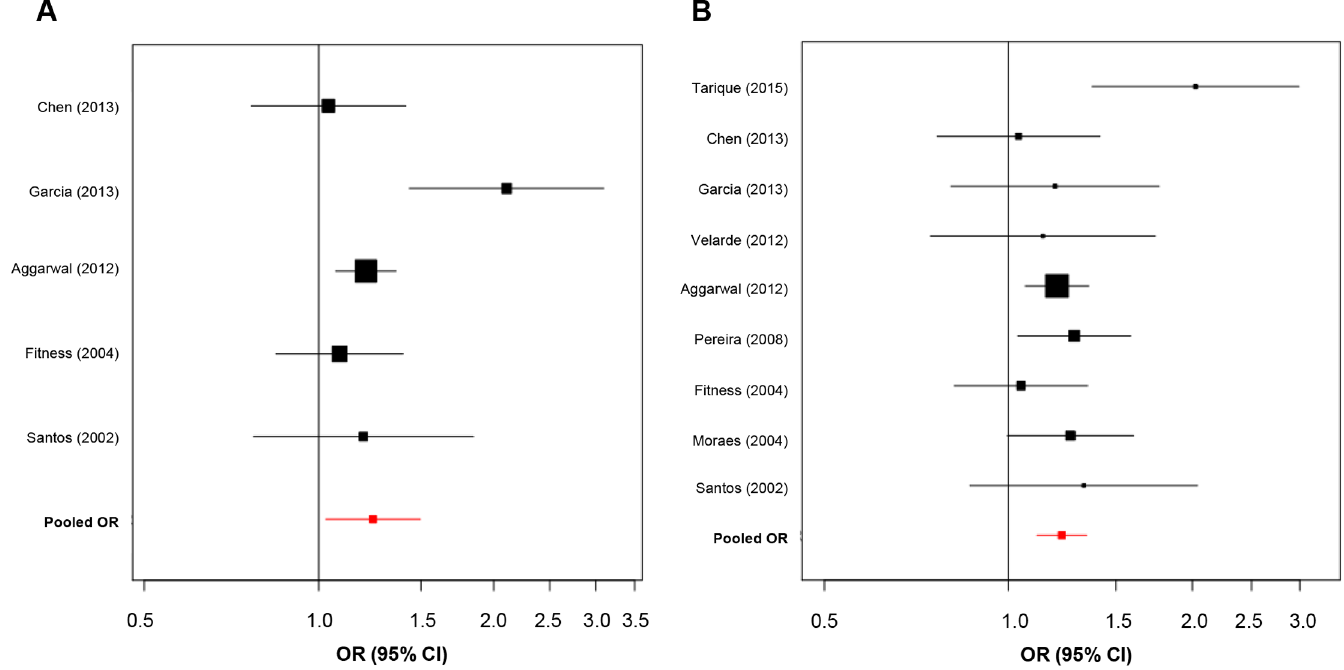
Fig 2. Forest plots summarizing association of IL10 promoter polymorphisms and leprosy. (A) Forest plot for -592 C > A (rs1800872). Five case-control studies were evaluated under random-effects model. Bars represent 95% confidence interval and boxes represent OR values. (B) Forest plot for -819 C > T (rs1800871). Nine case-control studies were evaluated under random-effects model. Bars represent 95% confidence interval and boxes represent OR values.